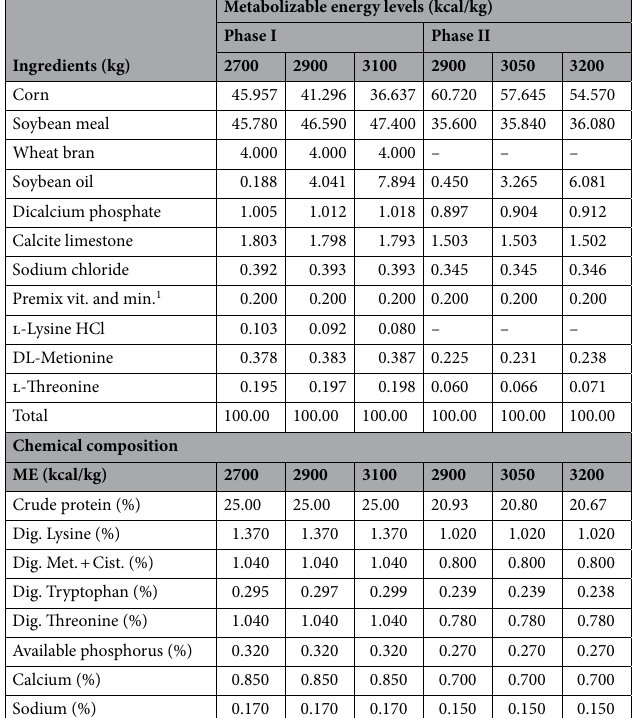
Table 7. Composition of experimental diets. 1 Warranty levels per kg of product: Folic acid (min.) 200 mg; pantothenic acid (min.) 5350 mg; copper (min.) 4000 mg; iron (min) 20 g; iodine (min.) 1500 mg; manganese (min.) 75 g; niacin (min.) 19.9 g; selenium (min.) 250 mg; Vit. A (min.) 8,000,000 IU; Vit. B12 (min.) 10,000 mcg; Vit. B2 (min.) 4000 mg; Vit. B6 (min.) 1000 mg; Vit. D3 (min) 2,000,000 IU; Vit. E (min.) 15,000 IU; Vit. K3 (min.) 2000 mg; zinc (min.) 50 g. Dig. Met. + Cist: digestible Methione + Cystine.